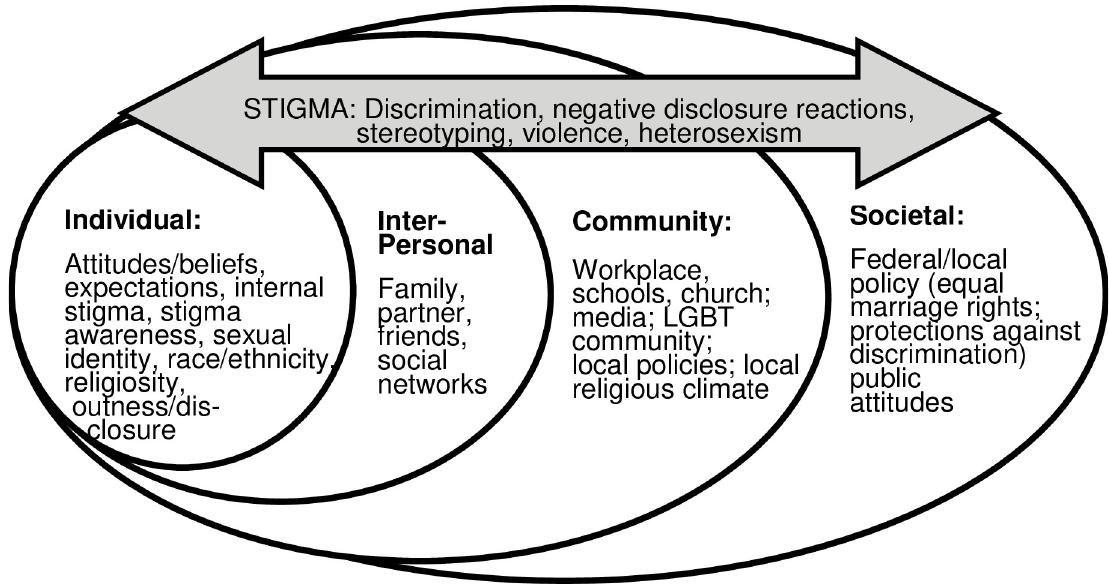
Fig 1. Social-ecological model: Impact of equal marriage rights among sexual minority adults.